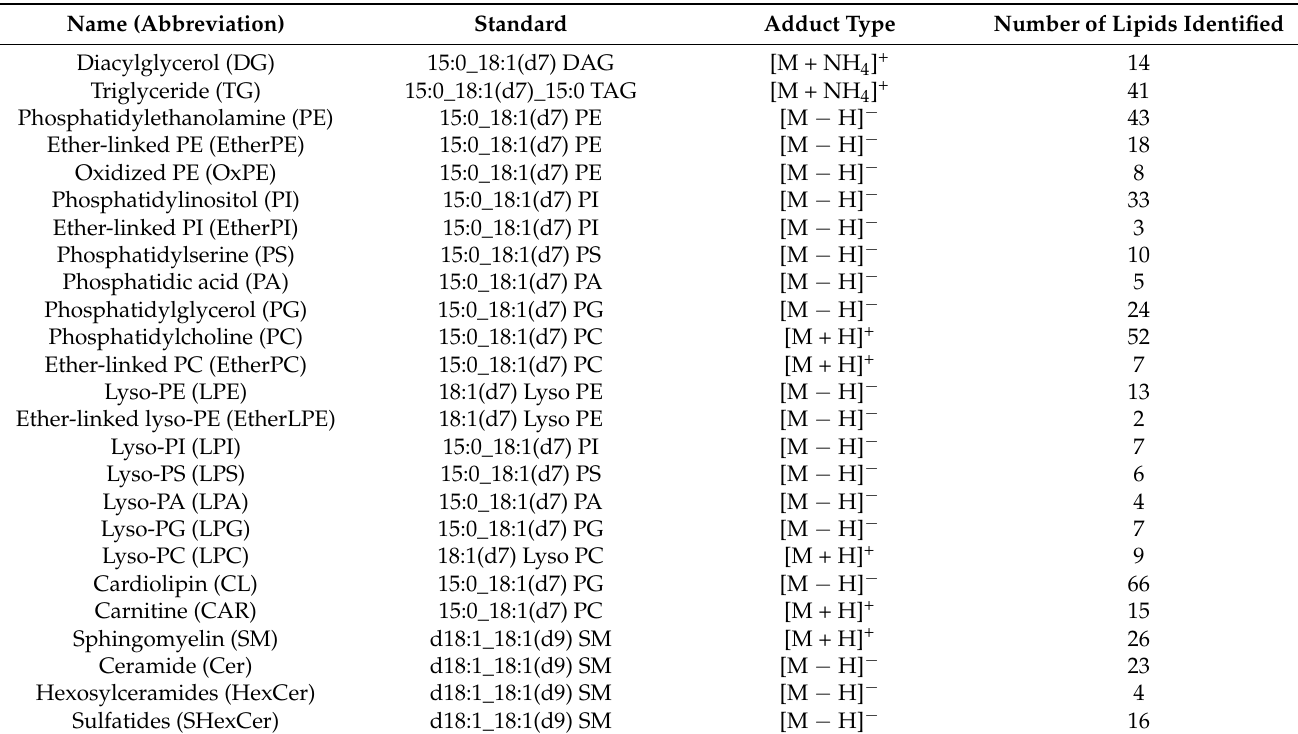
Table 1. List of lipid standards, adduct type and number of lipids that were identified in each